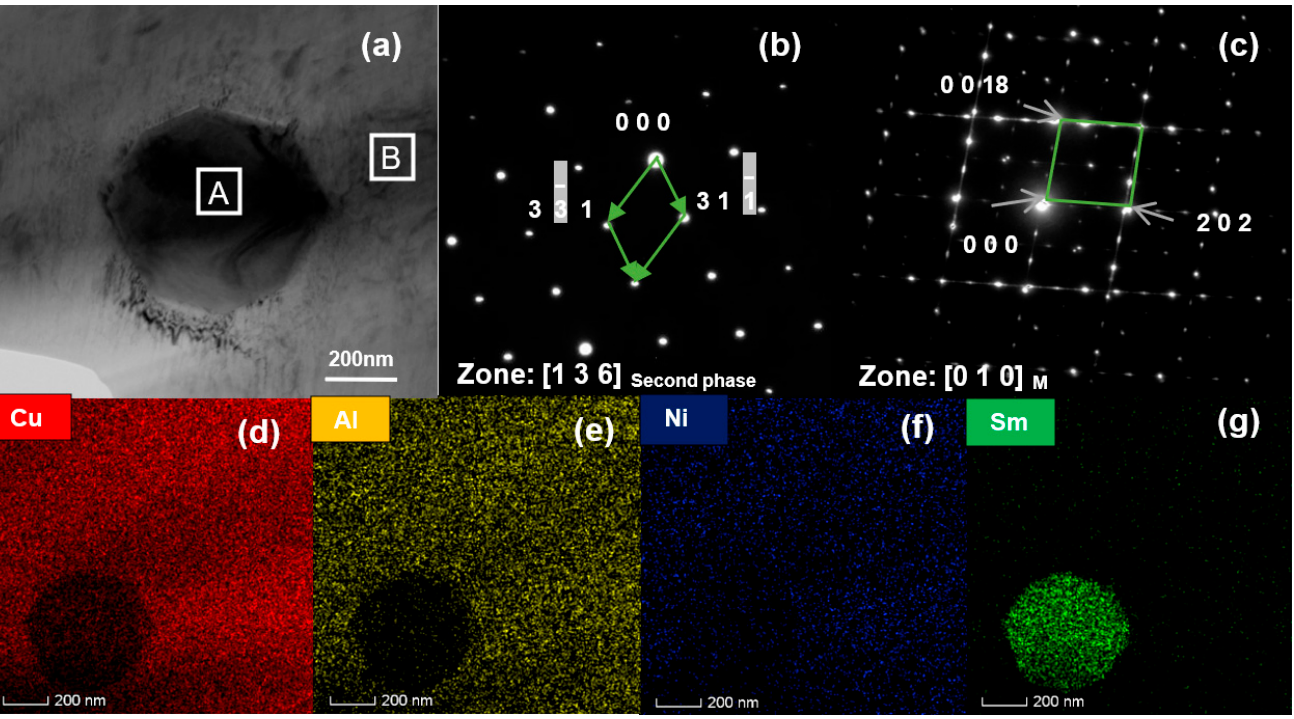
Figure 3. ( a ) The transmission photograph of the second phase in the Cu-13.0Al-4.0Ni-0.5Sm alloy; ( b ) the electron diffraction of the selected area A in ( a ); ( c ) the electron diffraction of the selected area B in ( a ); ( d – g ) EDS surface scan pictures of Cu, Al, Ni, and Sm.